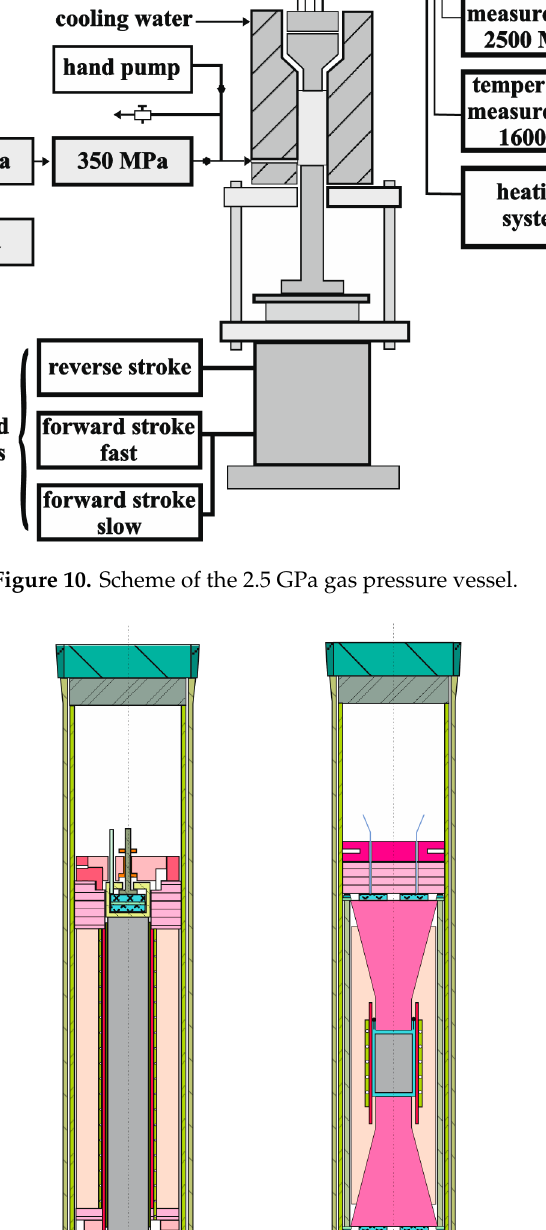
Figure 11. Two different measurement devices with sample encapsulation for the 2.5 GPa gas Figure 11. Two di ff erent measurement devices with sample encapsulation for the 2.5 GPa gas pressure vessel. pressure